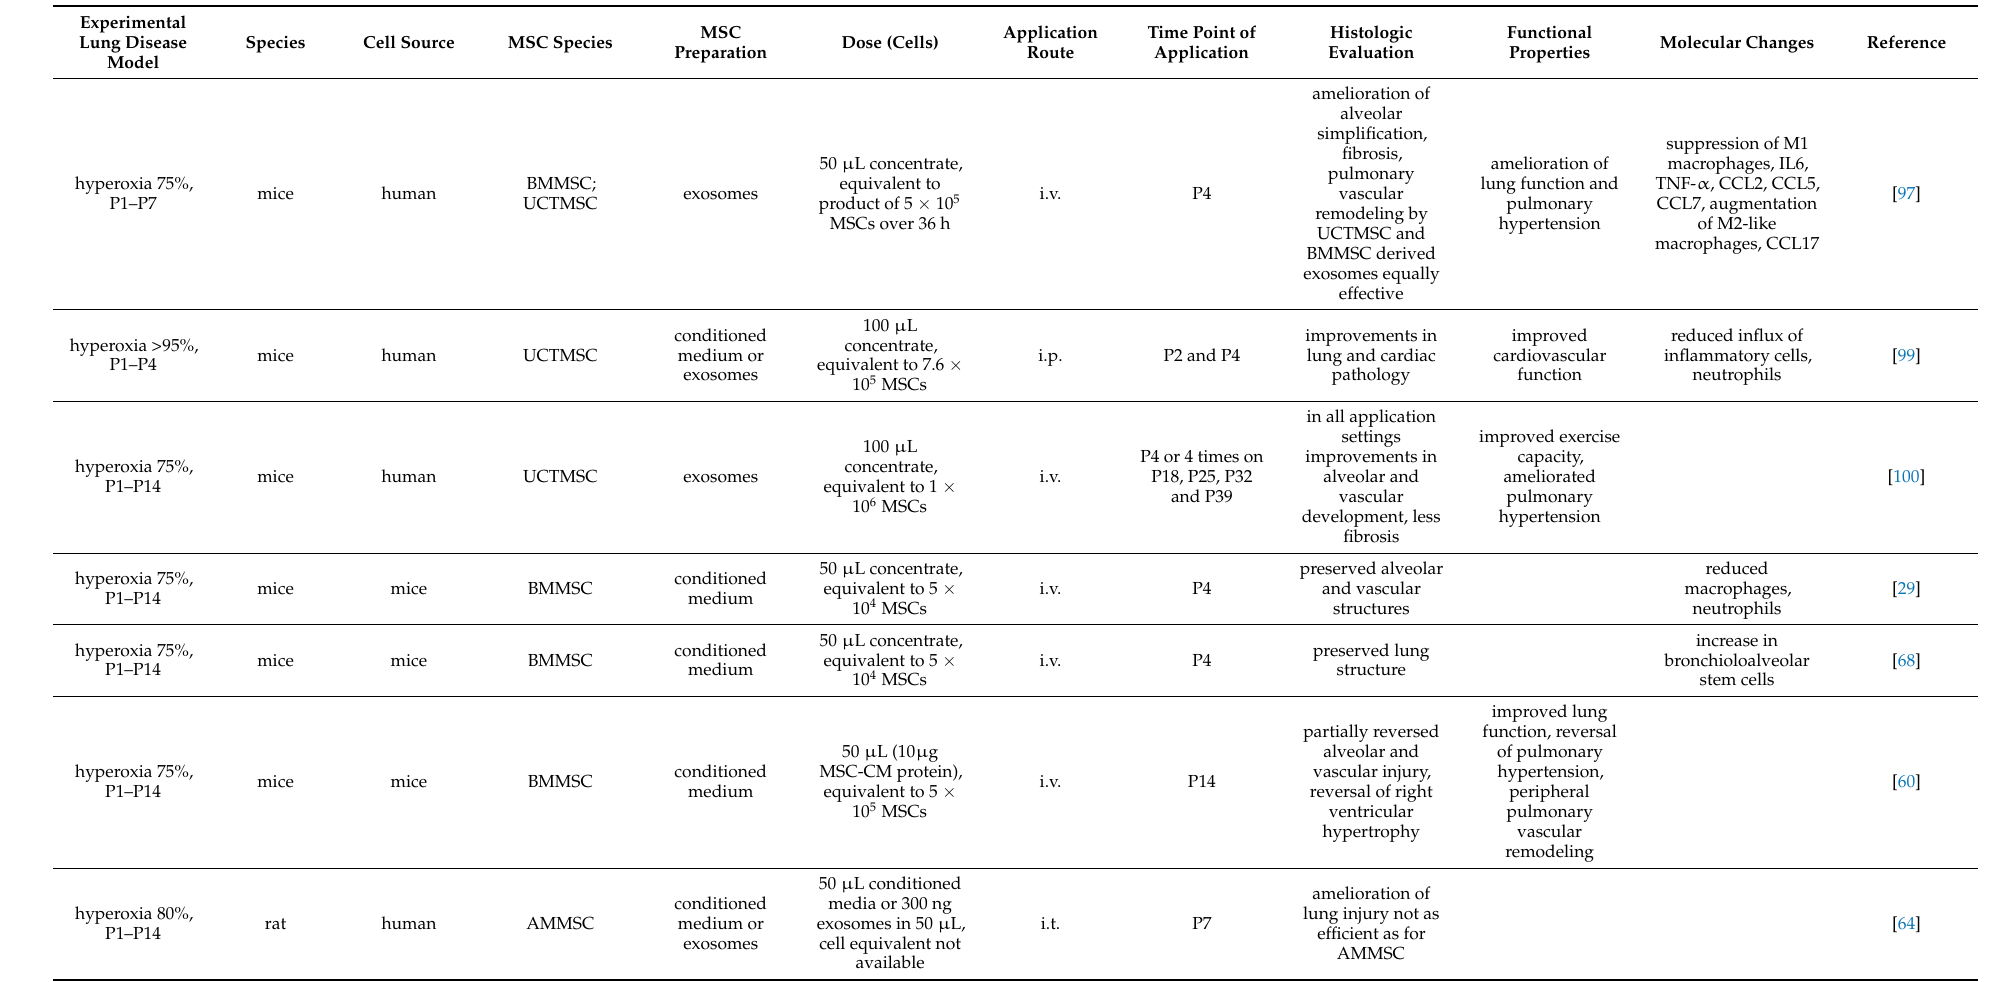
Table 5. Efficacy of MSC derived therapeutics (extracellular vesicles/conditioned media) in BPD rodent